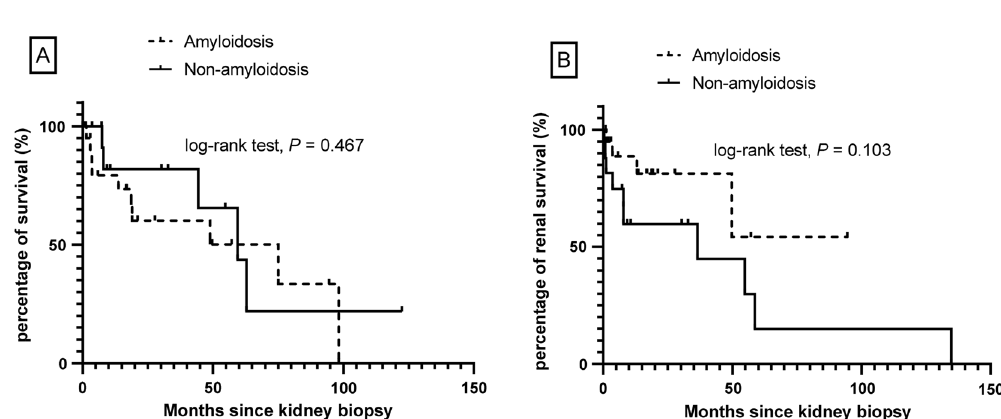
Figure 1. ( A ) Overall survival of IgM-MGRS in patients with IgM Monoclonal Gammopathy from time of kidney biopsy. ( B ) Kidney survival of IgM-MGRS in Patients with IgM Monoclonal Gammopathy from the time of kidney